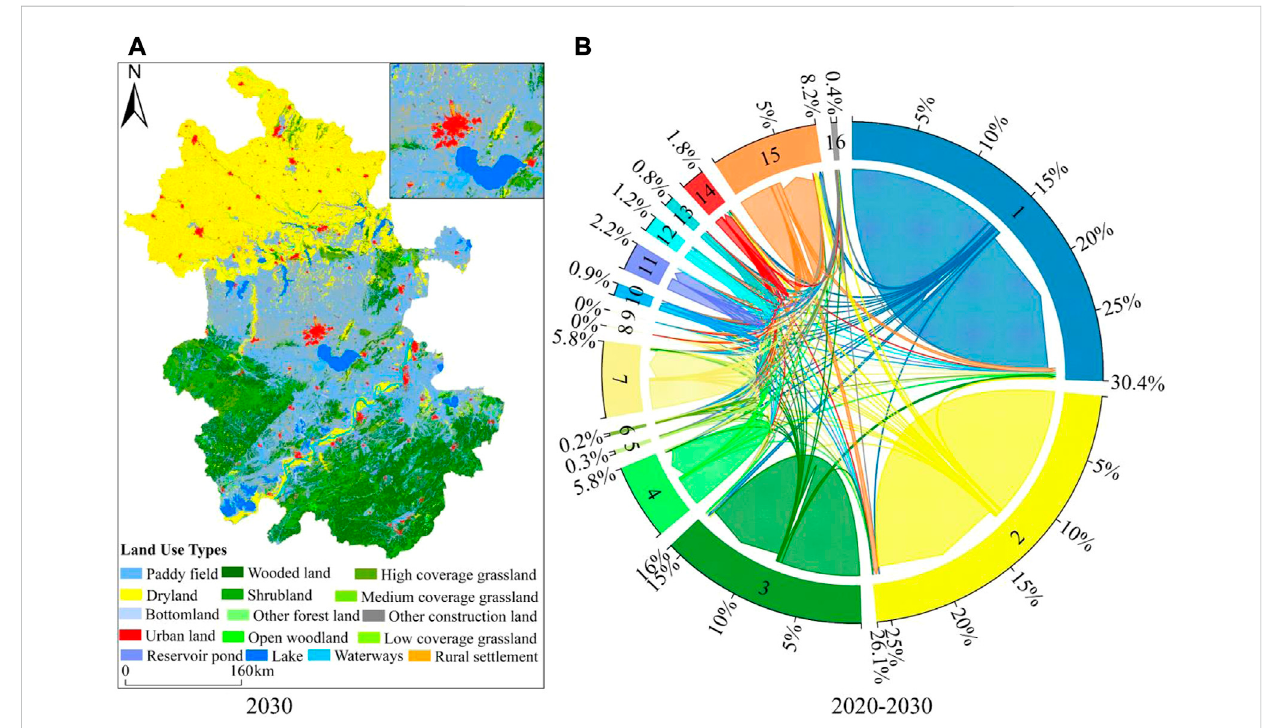
FIGURE 12 (A) Land use simulation in 2030, (B) Land use transfer in the period 2020 – 2030.